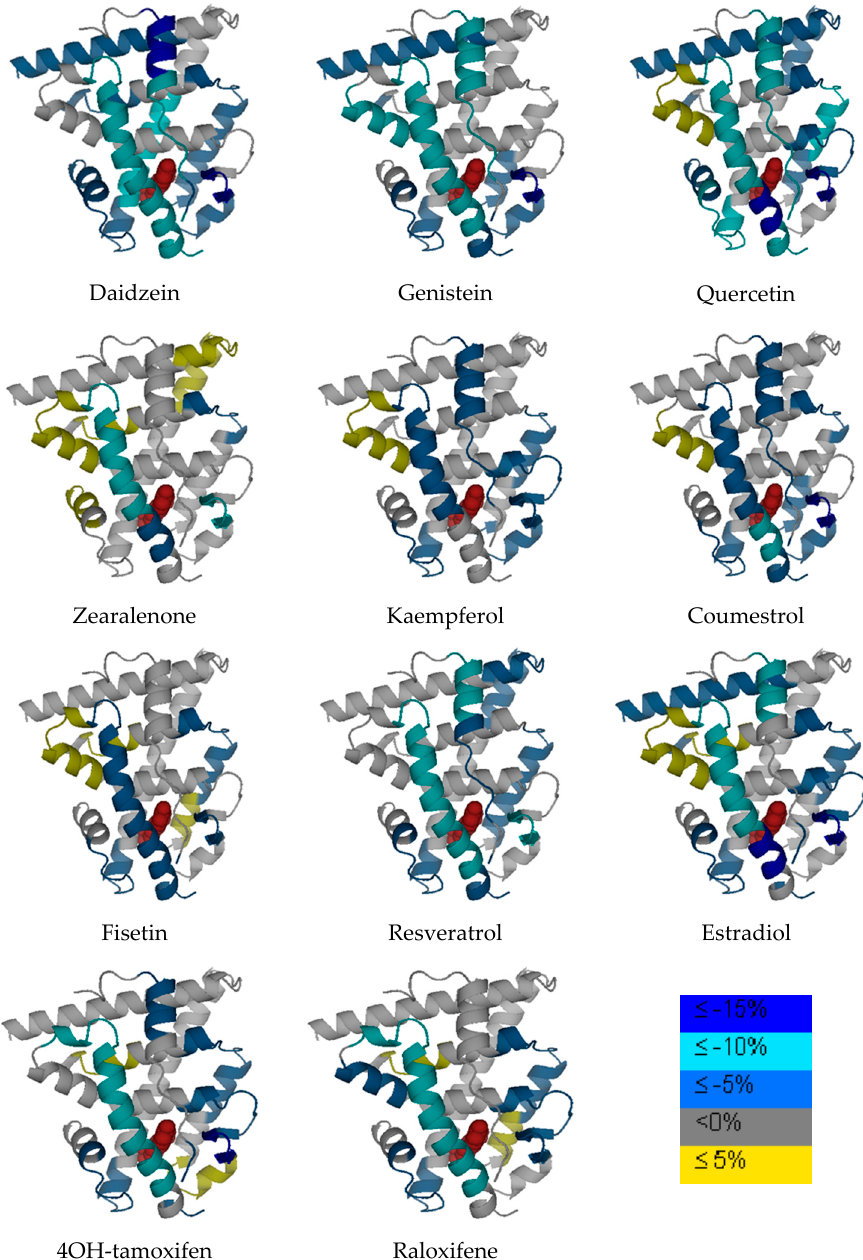
Figure 3. ER α LBD-ligand HDX profiles overlaid onto the ER crystal structure of estradiol (PDB ID: 1ERE). The color legend shows the deuterium incorporation difference by subtracting deuterium incorporation content of holo ER α LBD from apo ER α LBD. The compound showing in the protein ligand complex is estradiol for presentation purpose, but not representing the other compounds analyzed in this study.